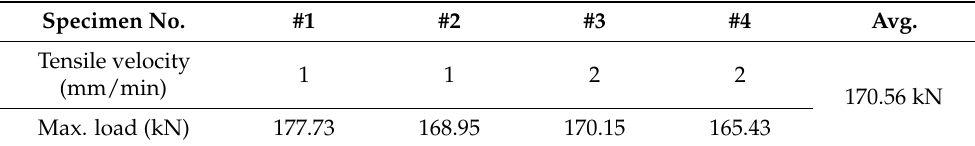
Table 2. Results of tensile